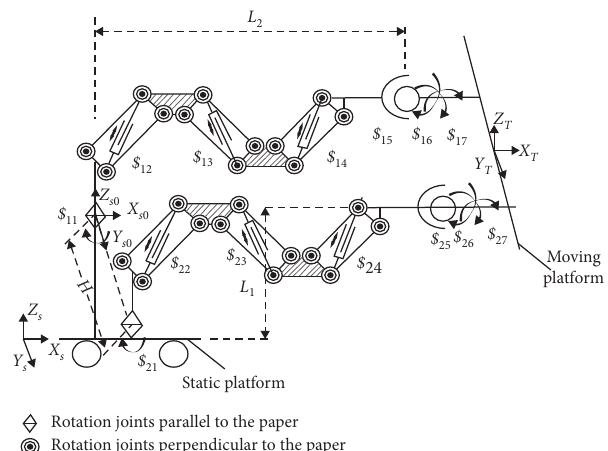
Figure 1: Parallel mechanism with two chains in the initial configuration.